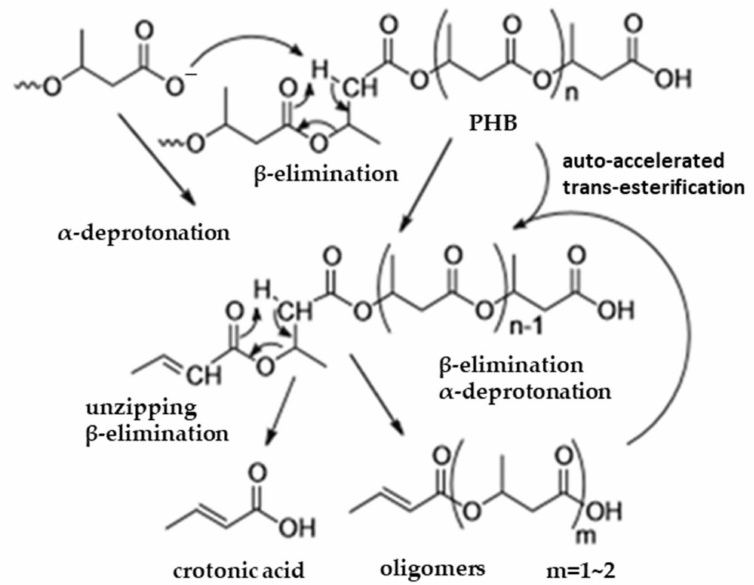
Figure 9. Thermal degradation of PHB toward crotonic acid, by H. Ariffin et al., reproduced with permission from [13]; published by Elsevier,